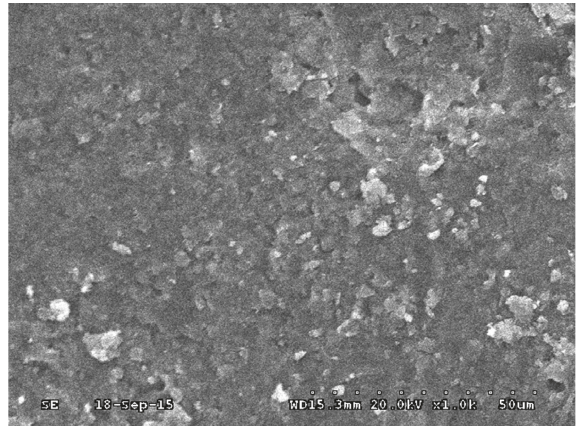
Figure 6: Microstructural feature of Pb-5000mg/kg contaminated soils stabilized by 15% cement under 9 freeze-thaw